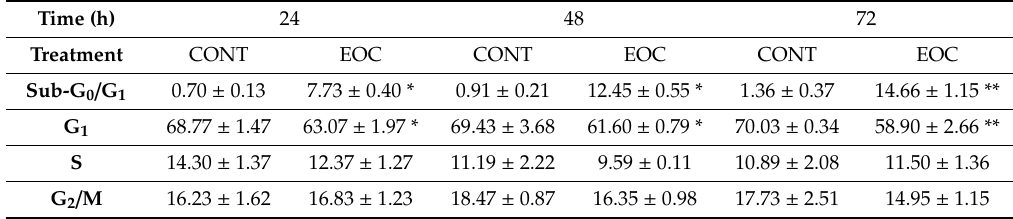
Table 4. The cell cycle distribution in MCF-7 cells after EOC